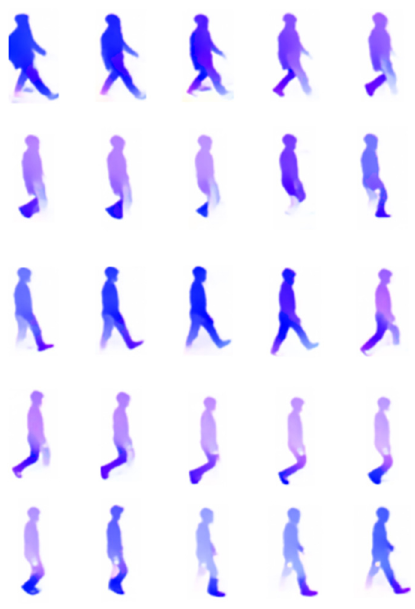
Figure 5. Pedestrian optical flow ROI obtained by FlowNet2.0 and YOLOv2.